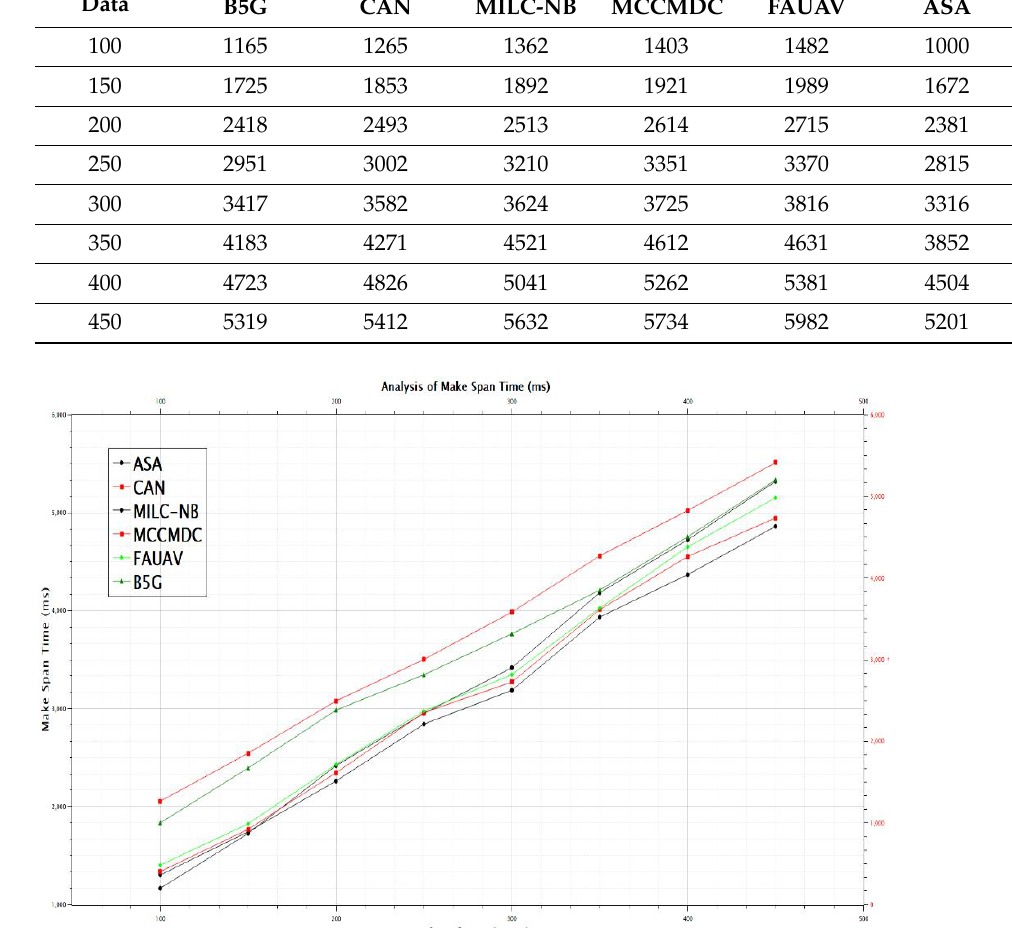
Figure 9. The Make span Before Cryptosystem Assumption.